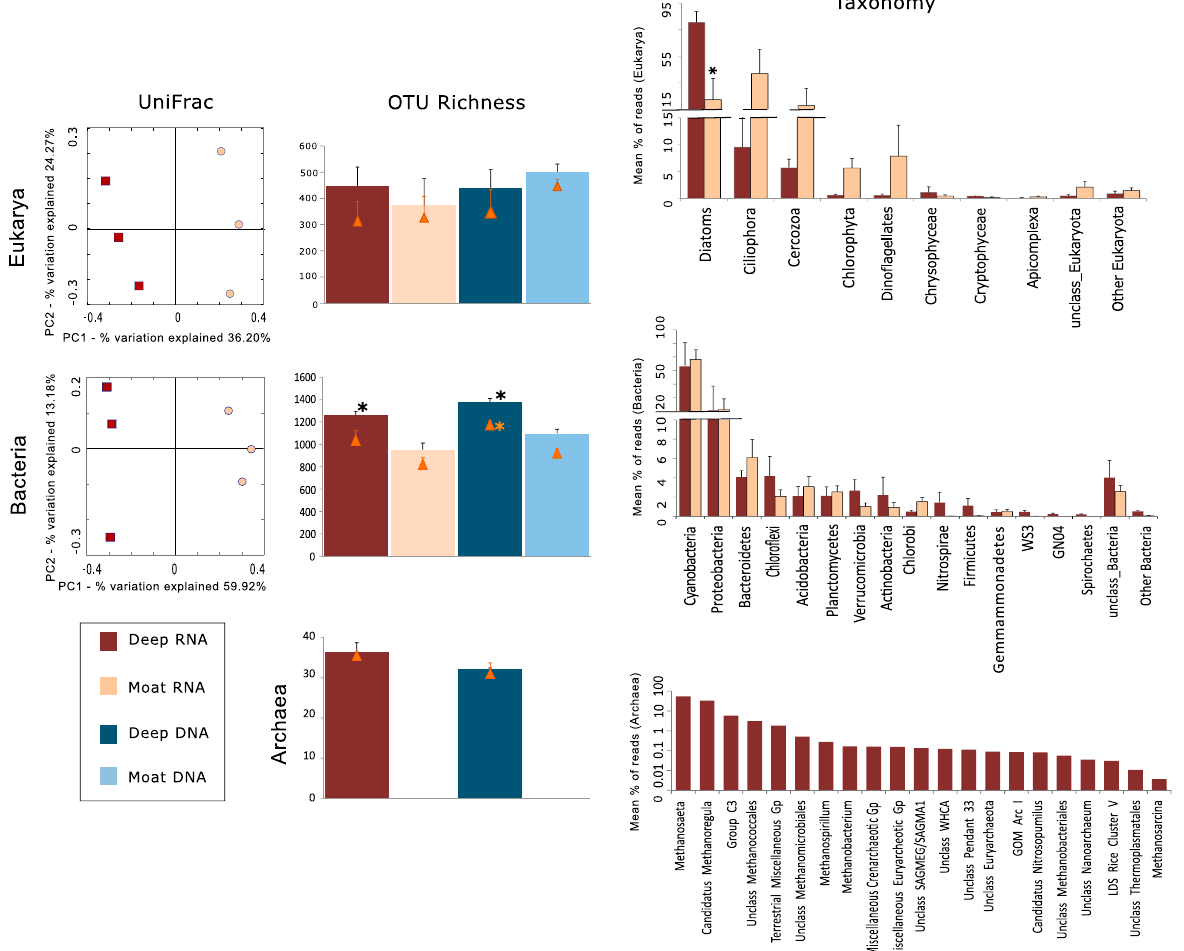
Fig. 2 Comparison of microbiome structure in the deep and moat bio fi lms in Ward Hunt Lake. Left panel : PCoA plots showing the clustering of eukaryotic and bacterial rRNA samples according to the unweighted UniFrac metrics. Middle panel : Bar chart showing the Chao1 richness indices with standard error bars for triplicate rRNA and rDNA samples. Observed OTUs ( fi lled triangles ) with standard error bars are also indicated. Right panel : Taxonomic distribution for Eukarya (major groups), Bacteria (phyla) and Archaea (genera). Standard error bars are also shown. Asterisks indicate signi fi cant differences between deep vs. moat samples ( t -test, p < 0.05). The PCoA and taxonomic results shown are for the rRNA analysis; rDNA results are given in Supplementary Fig.